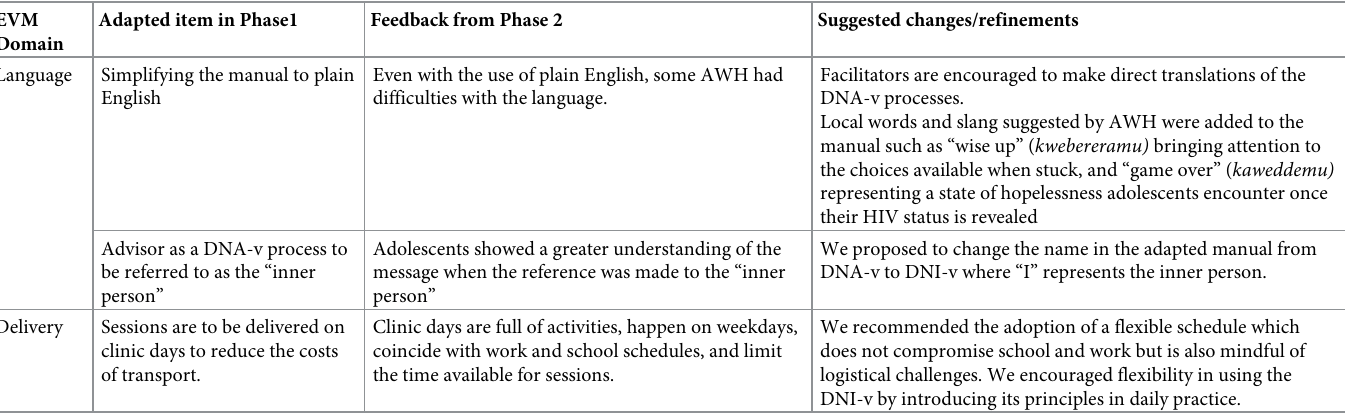
Table 2. Additional refinements to the DNA-v after the testing